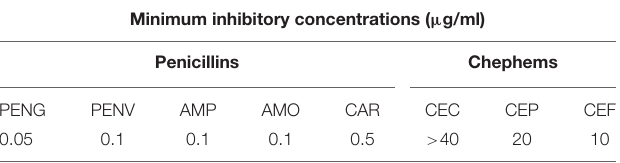
TABLE 1 | Minimum inhibitory concentrations of β -lactams against strain JCM 5343 T